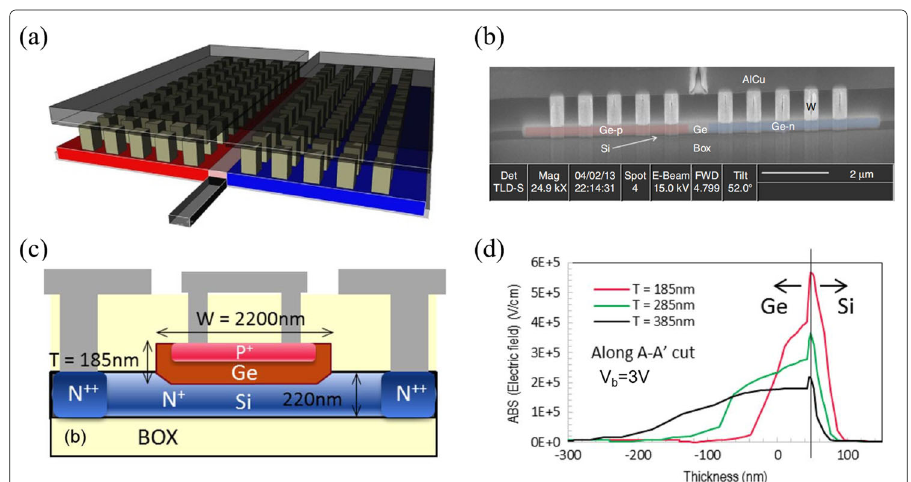
Fig. 10 a Schematic and b SEM image of the lateral p-i-n diode based Ge APD integrated in a silicon waveguide [112]; c Schematic cross-section and d electric field distribution profile of the waveguide-coupled Ge APD